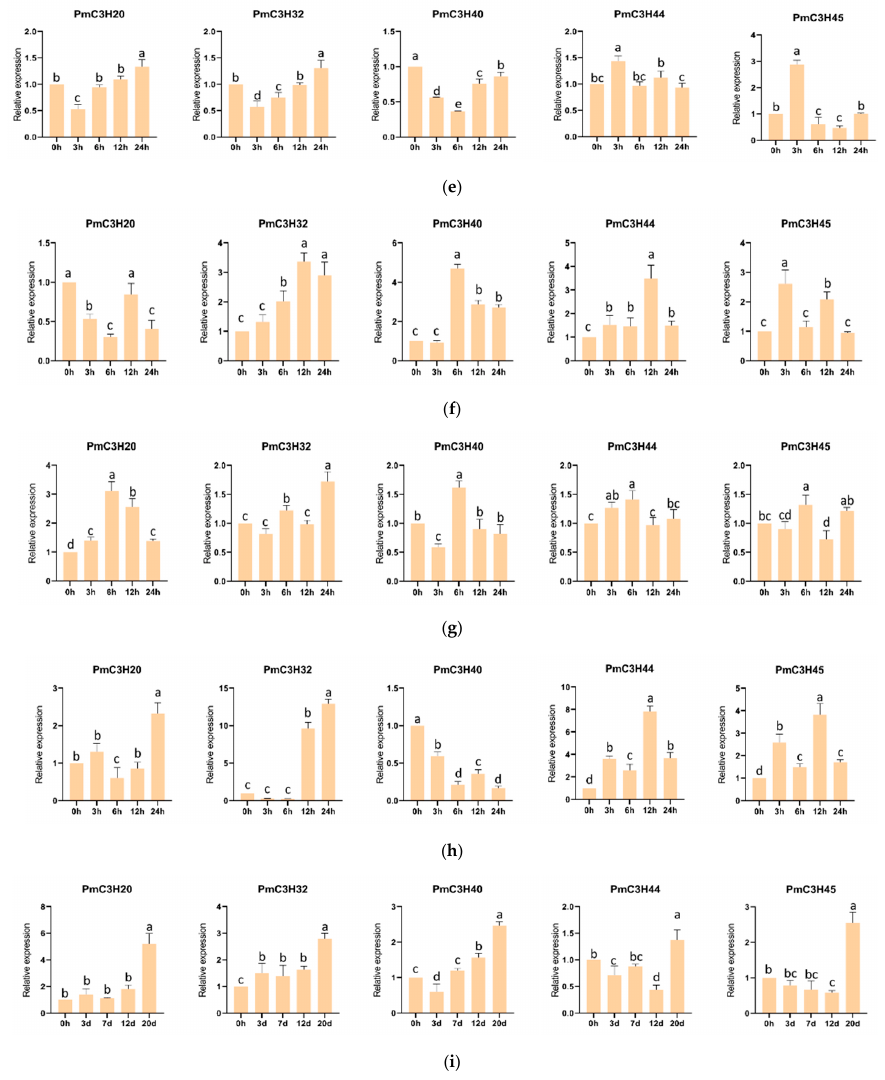
Figure 6. Expression profiles of five RR-TZF genes under different abiotic treatment. ( a ) ABA, ( b ) MeJA, ( c ) Mechanical injury, ( d ) SA, ( e ) H 2 O 2 , ( f ) ETH, ( g ) NaCl, ( h ) PEG, ( i ) Drought. Same lowercase letters between different columns indicate no significant difference. Completely different lowercase letters between different columns indicate a significant difference, p < 0.05. More than one lowercase letter in the same column indicate no significant difference between the column and other columns which contain one of the lowercase letters. The relative expression of 0 h was set as